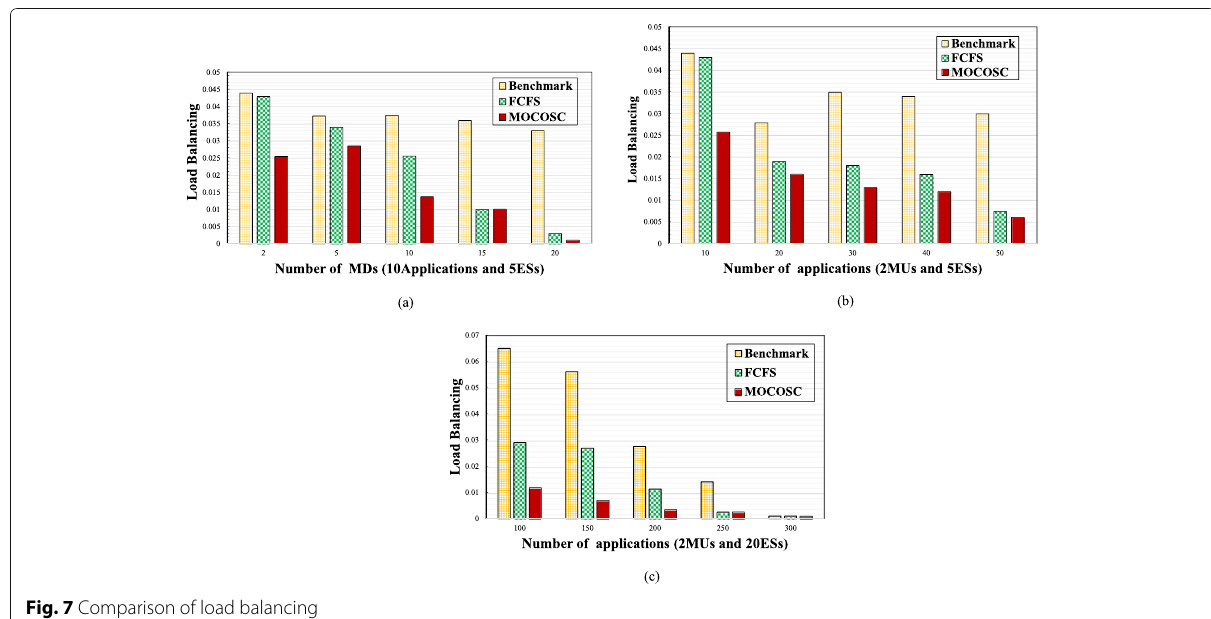
Fig. 7 Comparison of load balancing